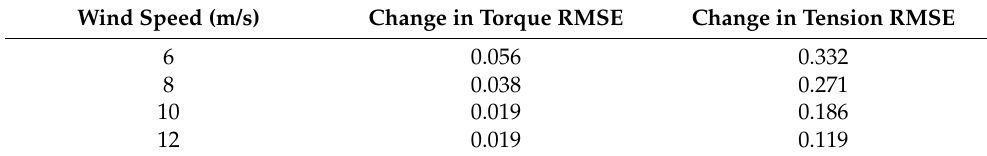
Table 2. Comparison of rotor velocity between the multi-spring and spring-disc models in RMSE. Wind Speed